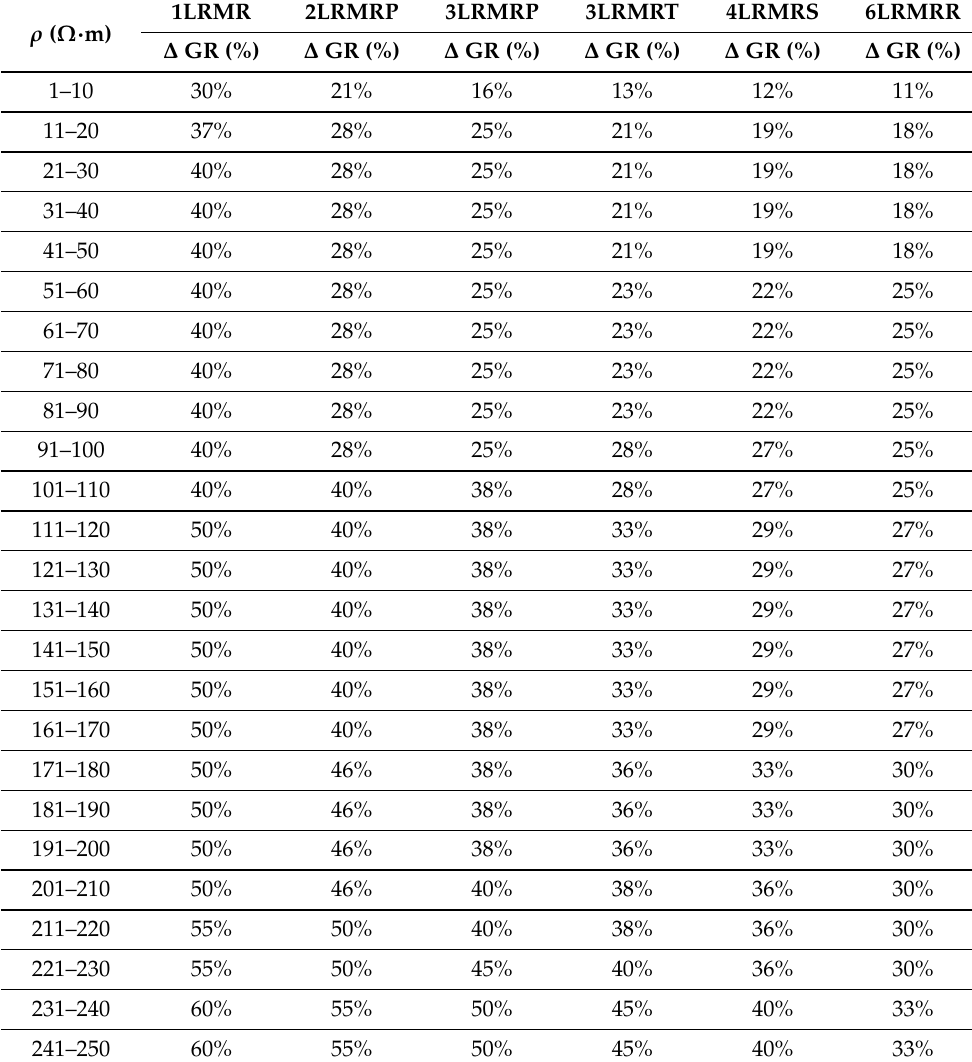
Table 12. LRM GR reduction by ground resistivity and GS